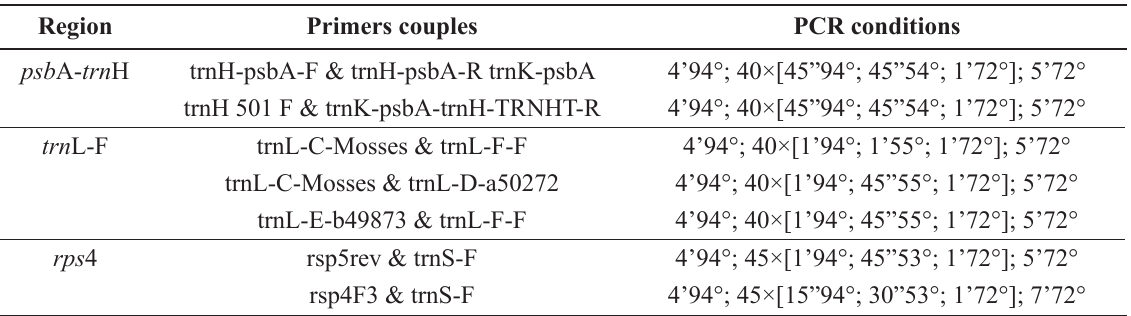
Table 2. List of PCR protocols used for each primer